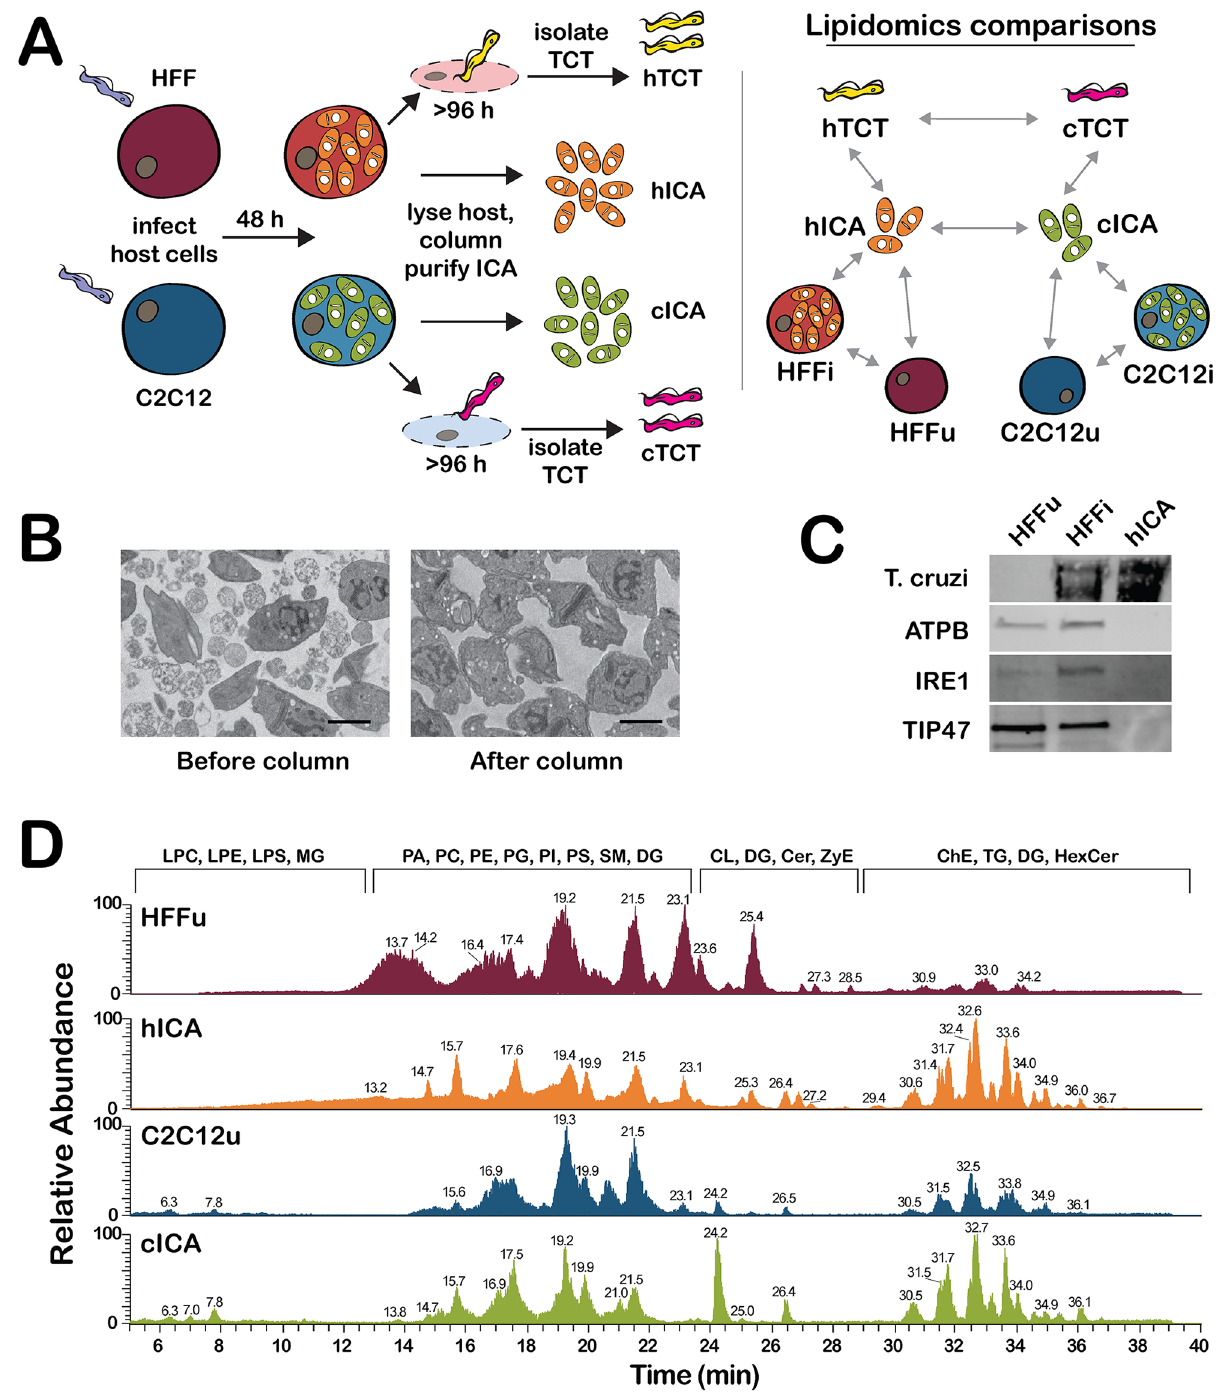
Fig 1. Overview of experimental design, evaluation of T . cruzi amastigote isolation and LC-MS/MS methods. (A) Schematic overview of the experimental approach that involved parallel lipidomics analysis of T . cruzi parasites isolated from two different mammalian cell types: C2C12 (mouse skeletal myoblast) and HFF (human foreskin fibroblasts). Host cell infection was established with T . cruzi trypomastigotes (TCT) and intracellular T . cruzi amastigotes (ICA) were isolated from infected host cells 48 hours post infection as detailed in the Methods. T . cruzi amastigote purity was evaluated using (B) transmission electron microscopy, scale bar = 2 μm, and (C) western blot analysis using antibodies to T . cruzi ,host mitochondria (ATP5B), endoplasmic reticulum (IRE1) and lipid droplets (TIP47) to probe whole cell lysates of control uninfected HFF ( HFFu ), T . cruzi -infected HFF (HFFi ), and T . cruzi amastigotes purified from HFF ( hICA ). (D) Positive ion mode base peak chromatogram of lipid extracts derived from C2C12, HFF, and cognate T . cruzi amastigote (cICA and hICA, respectively) analyzed by LC-ESI-MS/MS. The major lipid subclasses eluting at different retention times (min) are indicated above the chromatogram. TG–triacylglycerol, DG–diacylglycerol, Cer–ceramide, CerG–hexosylceramide, SM–sphingomyelin, LPC– lysophosphatidylcholine, PC–phosphatidylcholine, LPE–lysophosphatidylethanolamine, PE–phosphatidylethanolamine, LPS–lysophosphatidylserine, PS–phosphatidylserine, PI–phosphatidylinositol, PG–phosphatidylglycerol.